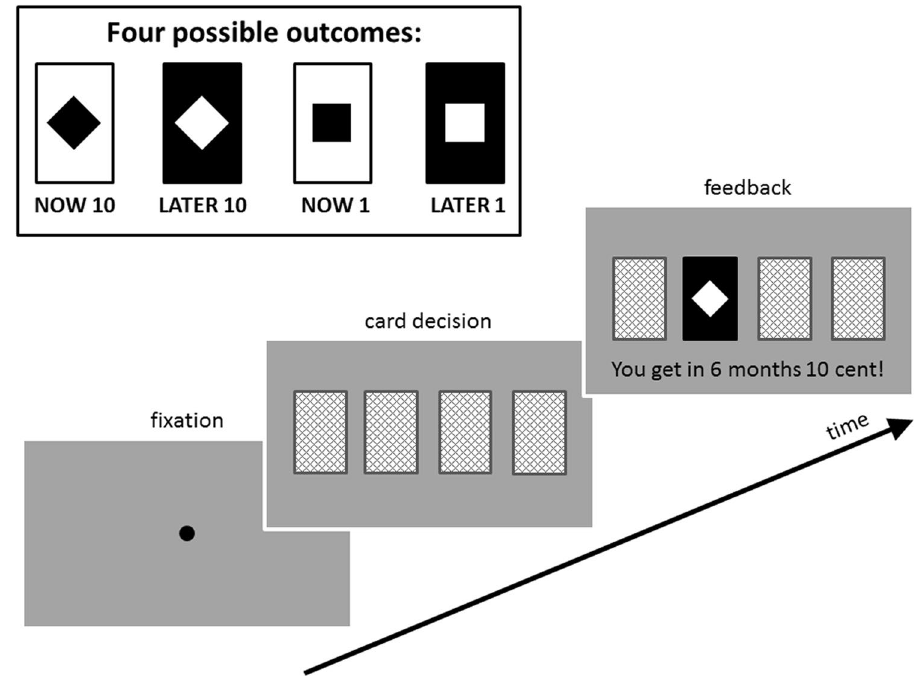
Figure 2. Task design. Four possible outcomes in the delayed gratification task (upper part) and a schematic illustrating the time-course of one trial of the task (lower